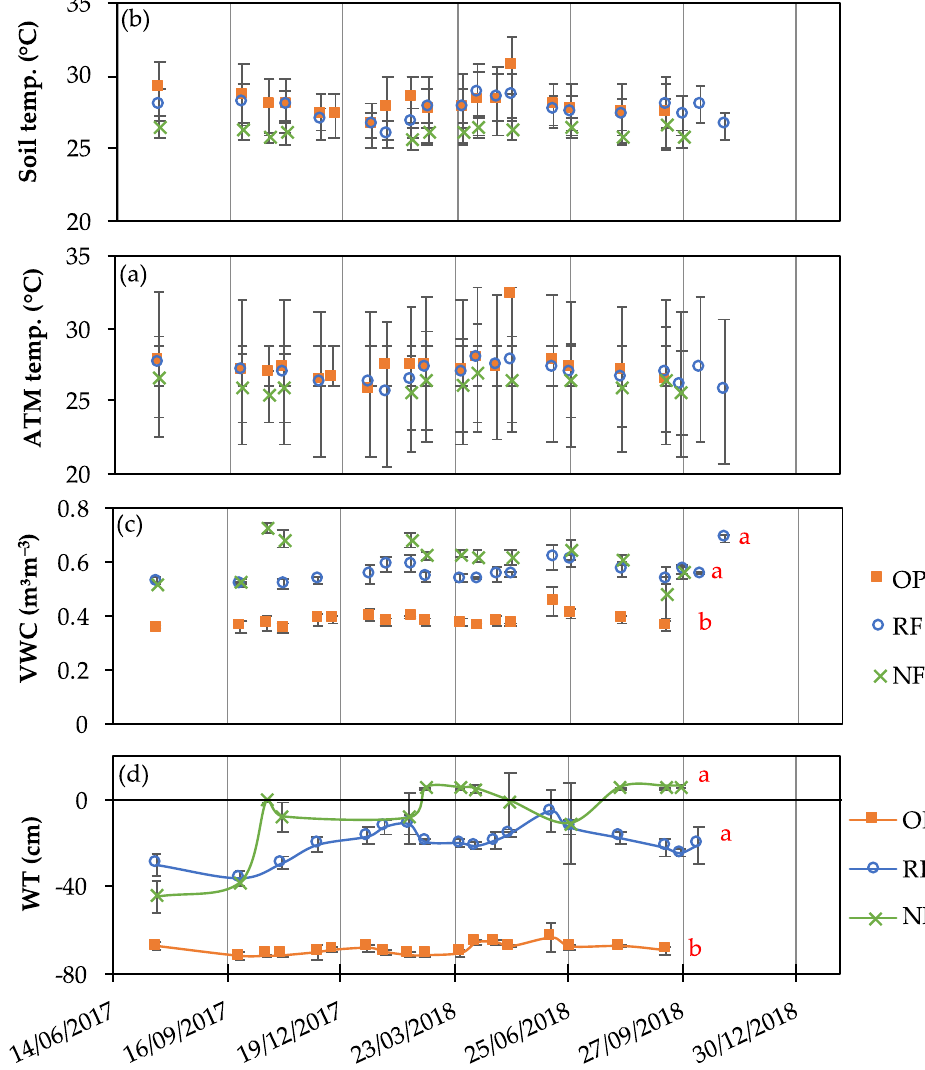
Figure 2. Environmental parameters at the drained oil palm plantation (OP), rewetting-restored forest (RF) and natural peat swamp forest (NF) sites in Raja Musa, Malaysia. ( a ) atmospheric temperature, ( b ) soil temperature, ( c ) soil moisture and ( d ) water table level. ATM: atmospheric. Error bars represent standard error of the mean. Note: different letters in red represent significantly different, α =